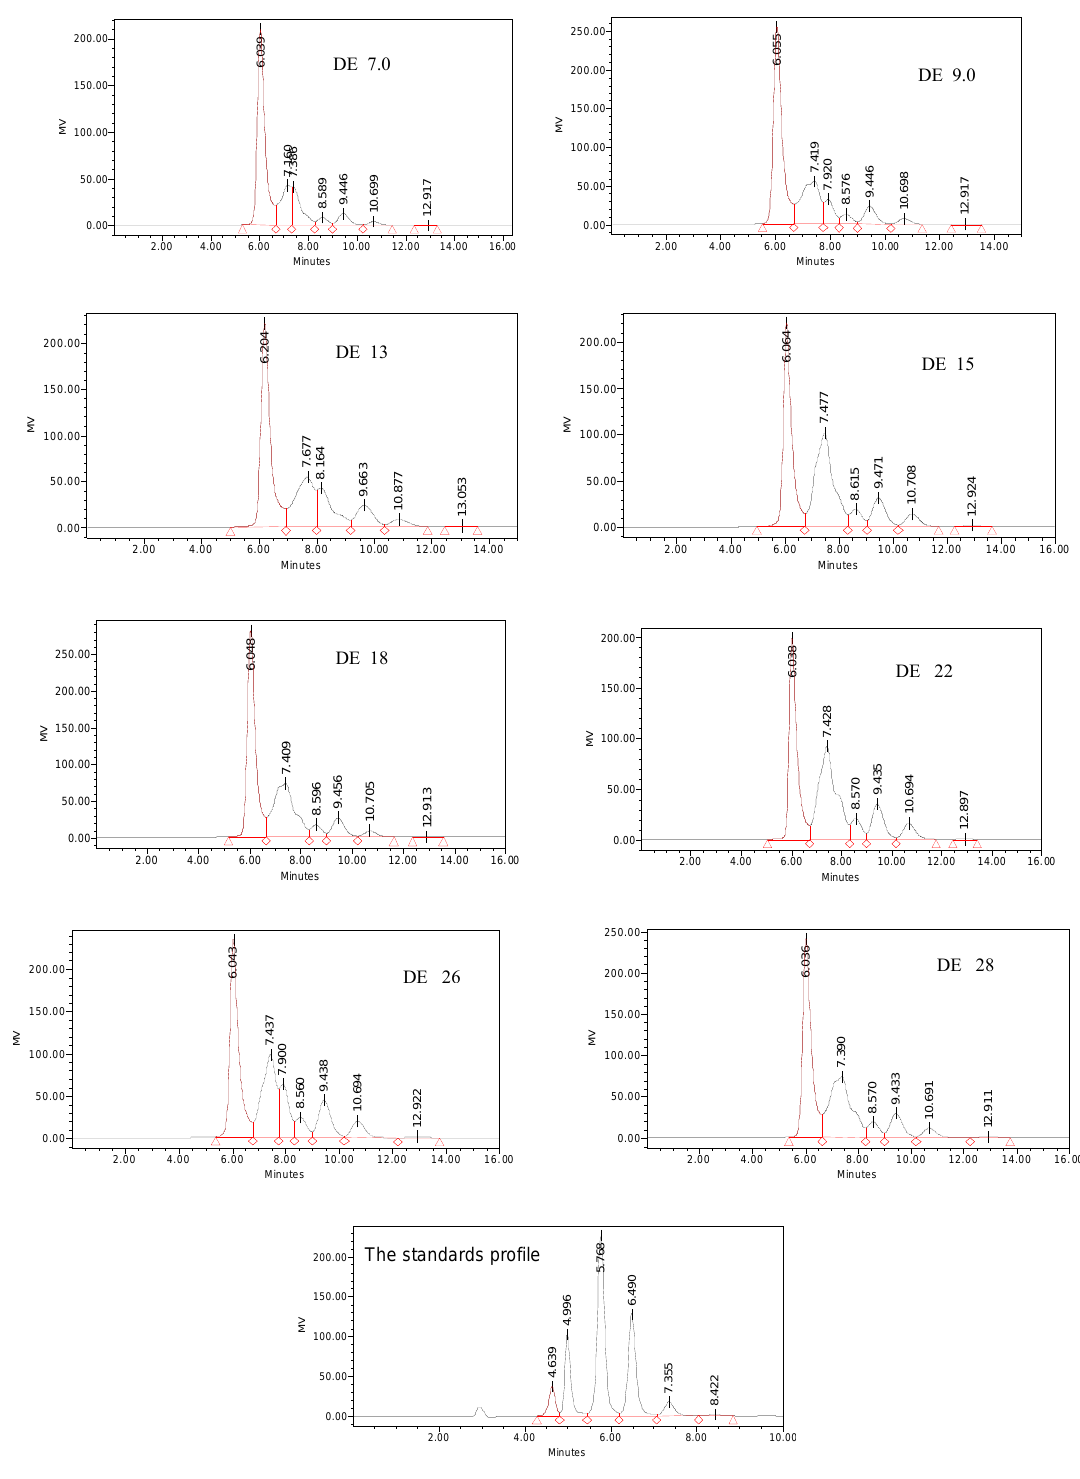
Figure 6. HPLC oligosaccharide profile of dextrin with different DE value. Number in the figure represented retention time of glucose and